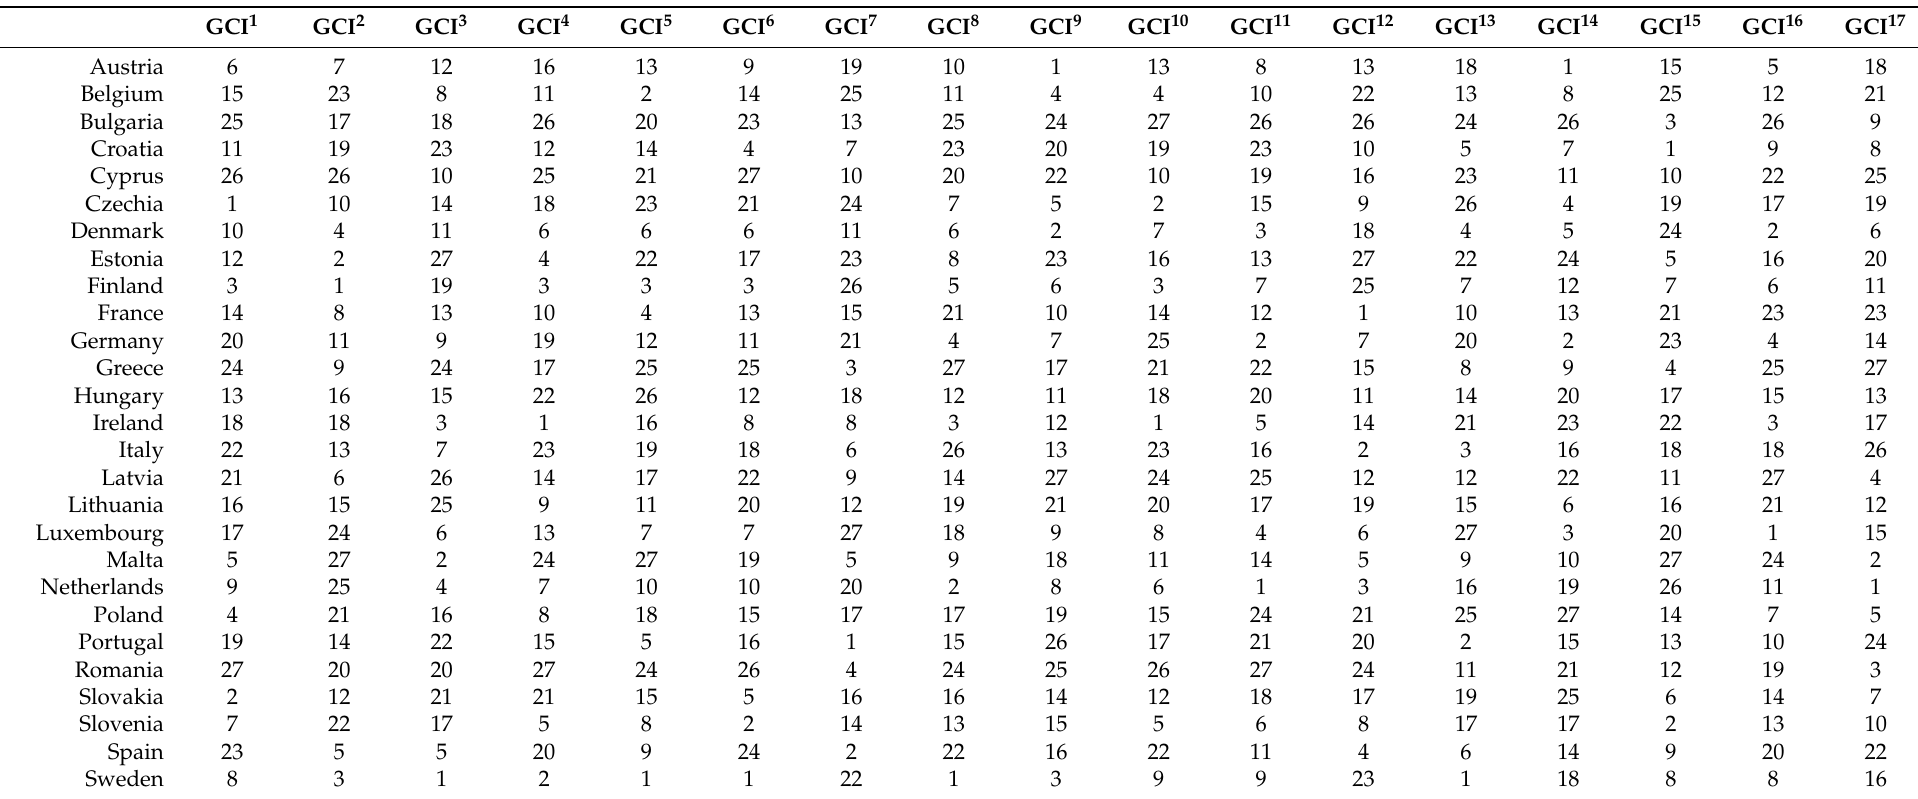
Table 6. Country’s performance rank order within goals 1 to 17 in